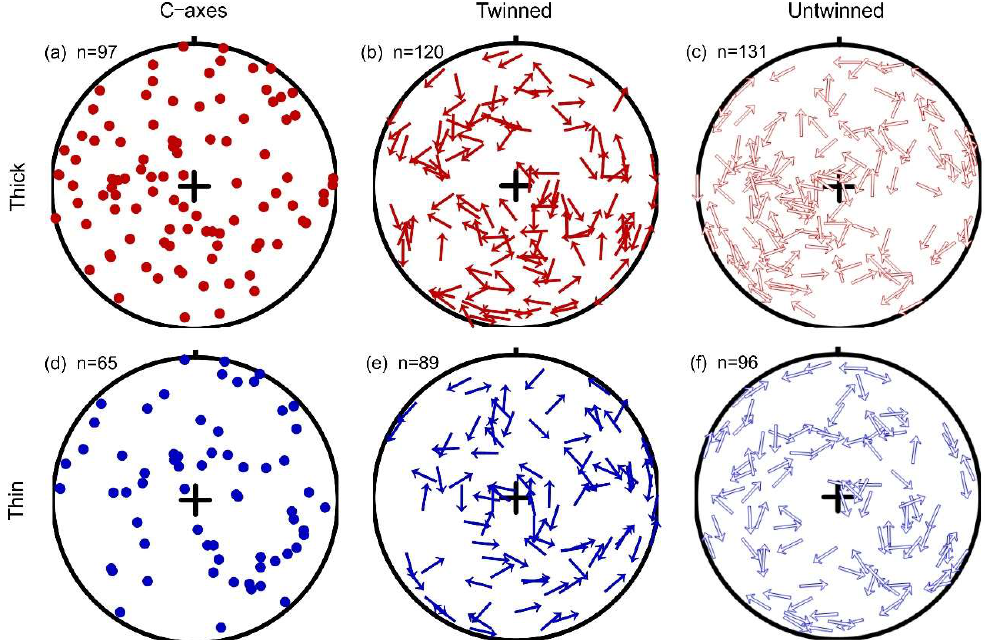
Figure 7. Microphotographs of calcite e-twins of limestone samples H20 (a), H36 (b–c), and H34 (d) in crossed polars. Often thin twins either crosscut thick twins or stop at them. Rarely thin twins are strictly confined to thick twins, e.g. at yellow arrows in (c).